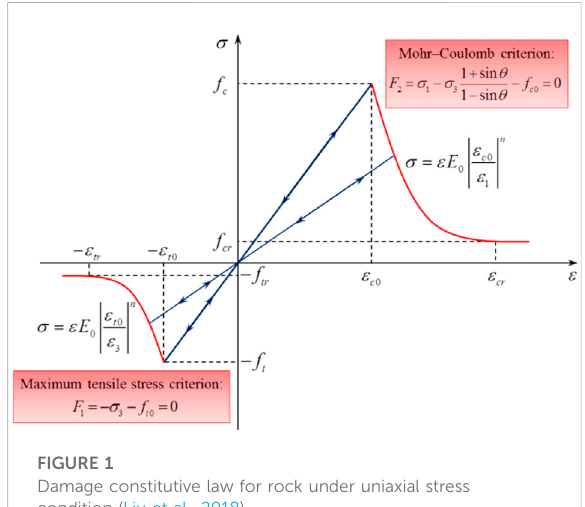
FIGURE 1 Damage constitutive law for rock under uniaxial stress condition (Liu et al.,